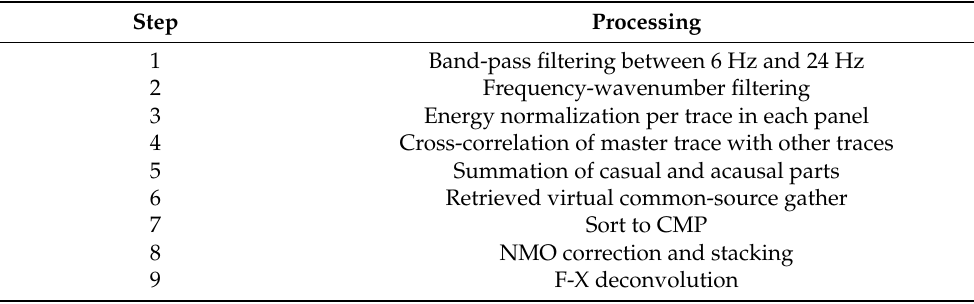
Table 1. Processing flow of the ANSI to construct the virtual seismic reflections .